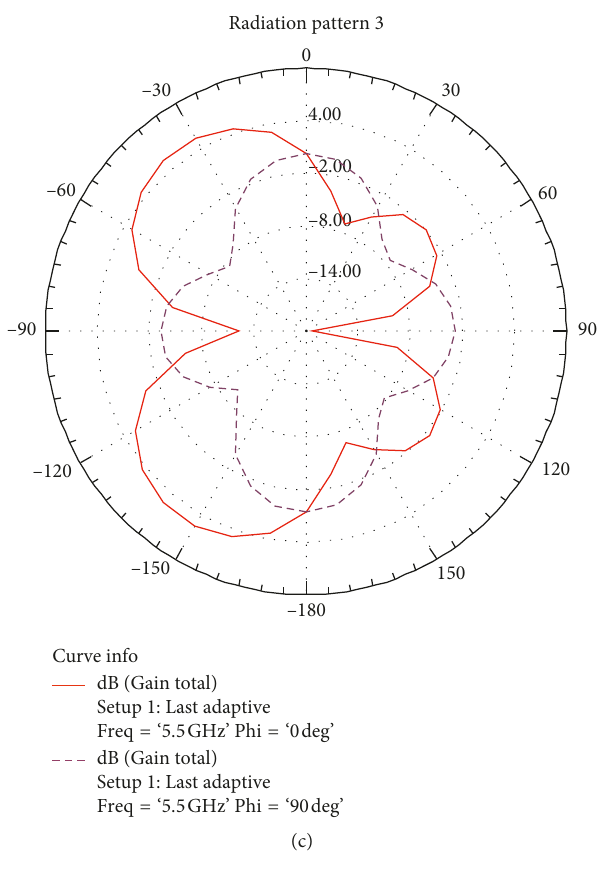
Figure 6: Radiation pattern of the optimized WLAN/WiMAX multiband MSA: (a) 2.45GHz, (b) 3.5GHz, and (c)